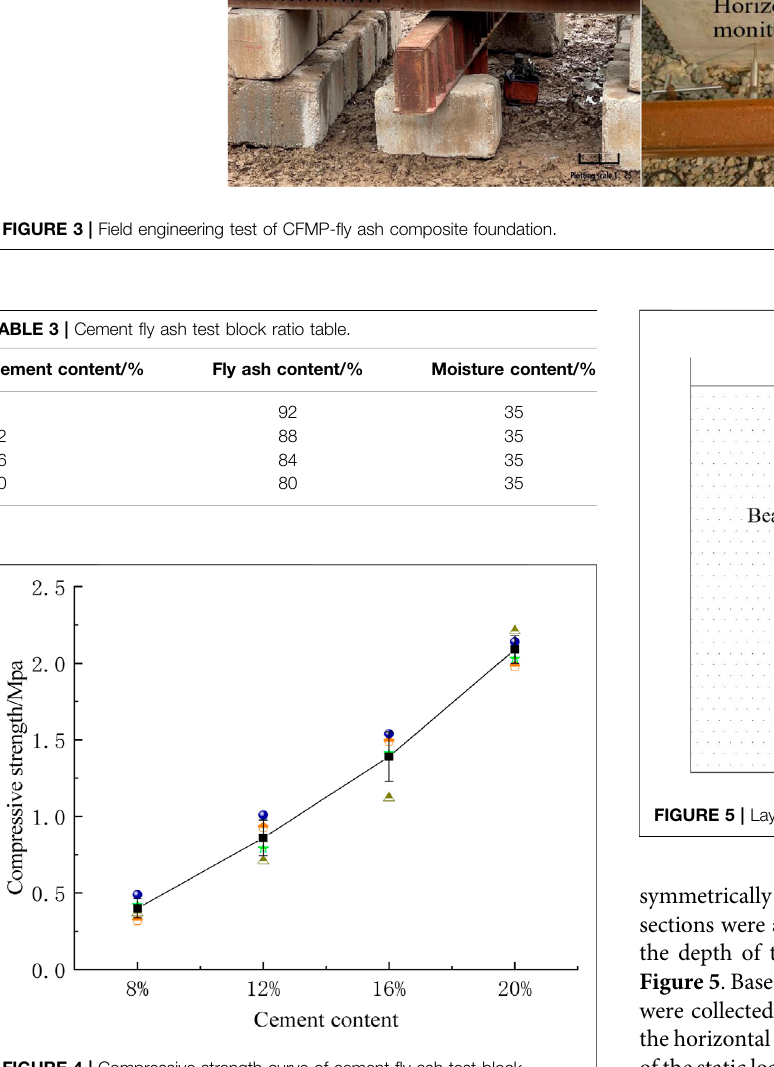
FIGURE 4 | Compressive strength curve of cement fl y ash test block.